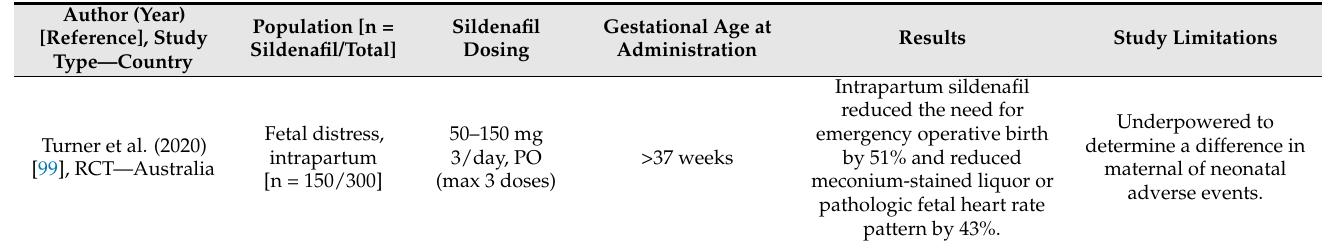
Table 4. Clinical studies assessing sildenafil for fetal